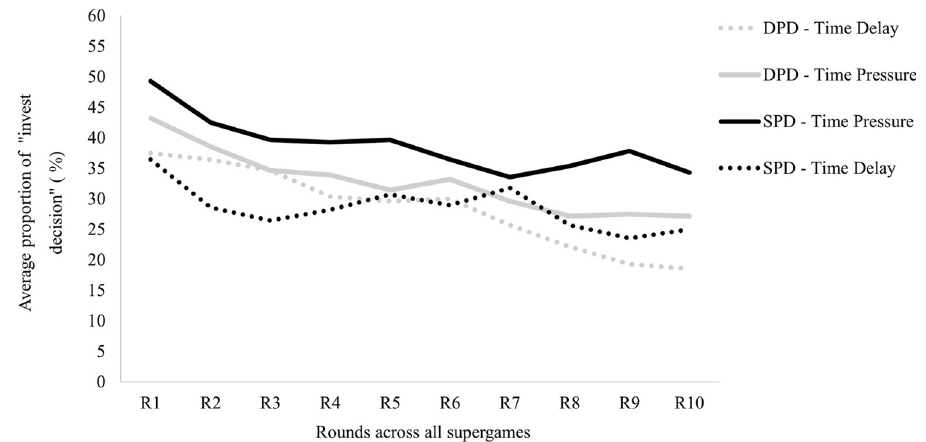
Fig 5. Mean cooperation rates across the rounds played in all supergames in the four conditions. n = 28 participants in each condition presented. A version of this figure with error bars is presented in the supporting information (S2 Fig).